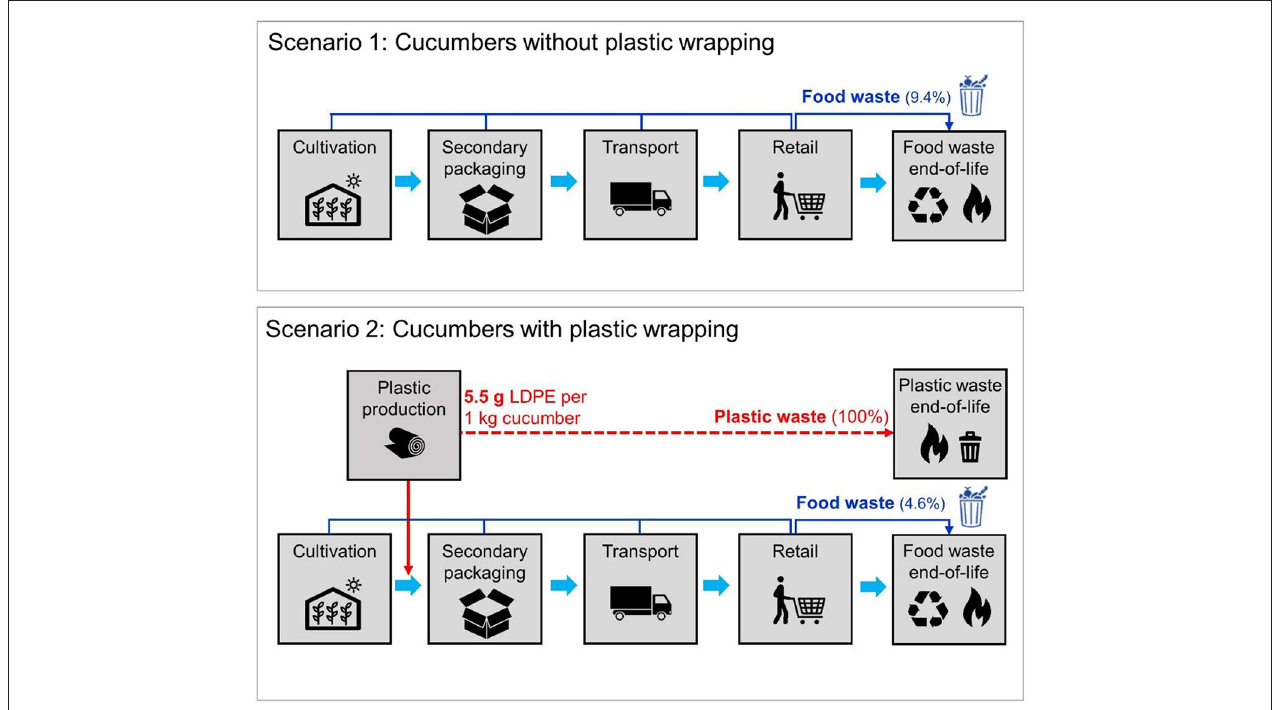
FIGURE 1 | Life cycle stages in the supply chain of cucumbers imported from Spain to Switzerland, corresponding to the two examined scenarios: without plastic wrapping (scenario 1) and with plastic wrapping (scenario 2). The share of food waste in both scenarios (i.e., 9.4 and 4.6%) has been accounted for in the calculations, so that 1 tonne of cucumber is sold at retail for both scenarios. This figure has been designed using resources from Flaticon.com.